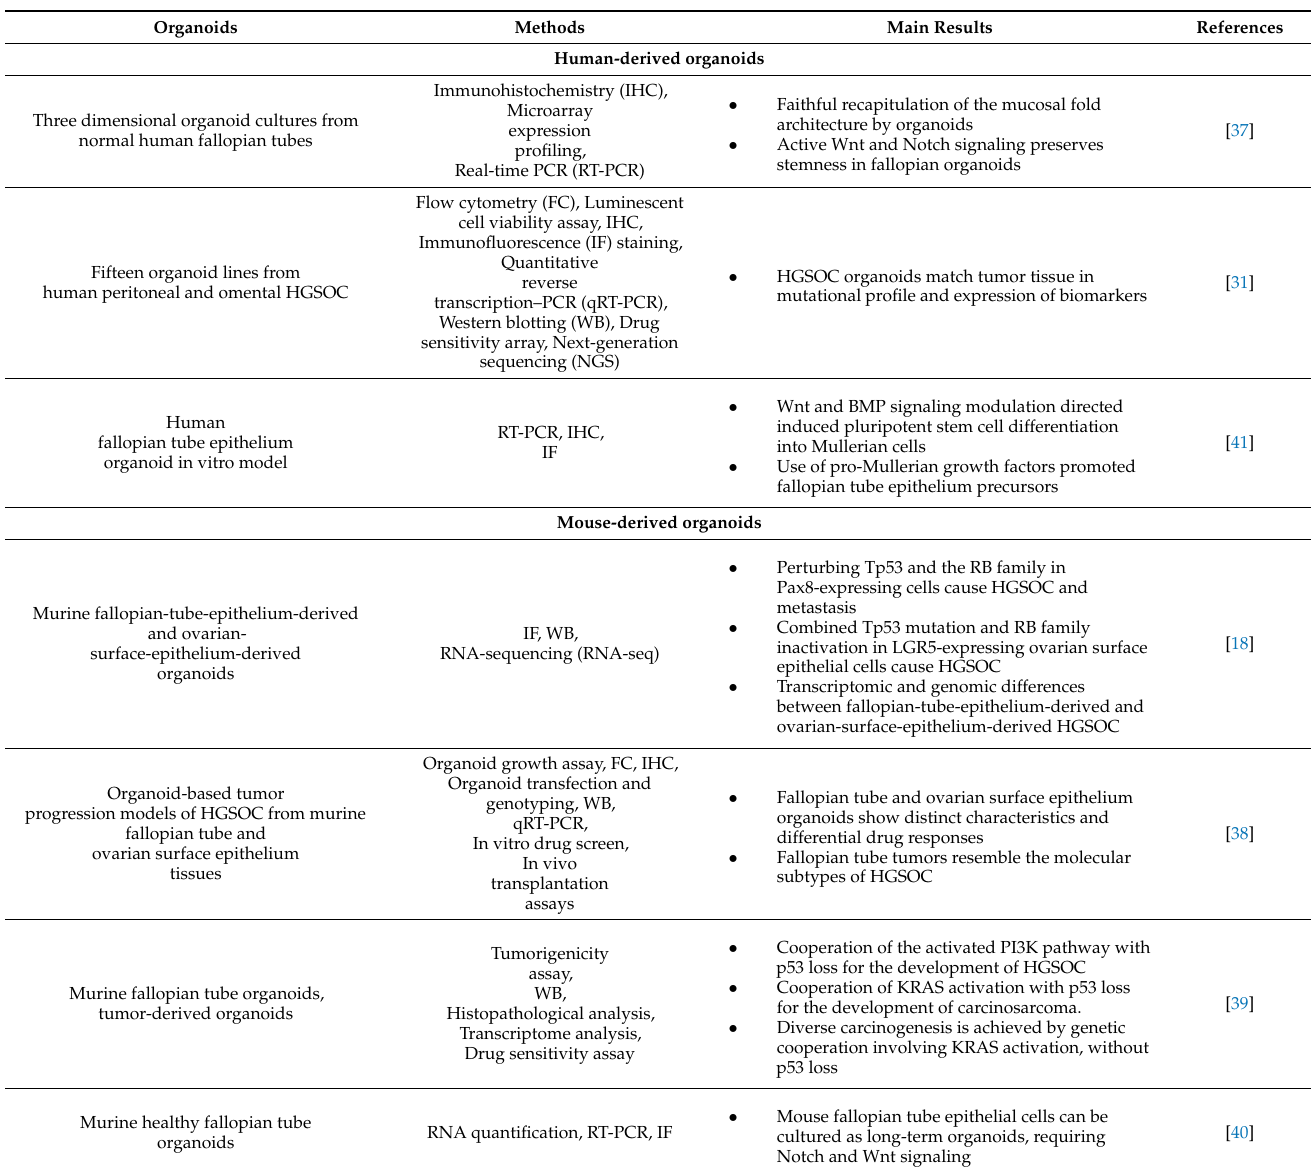
Table 1. The role of organoids in the assessment of HGSOC